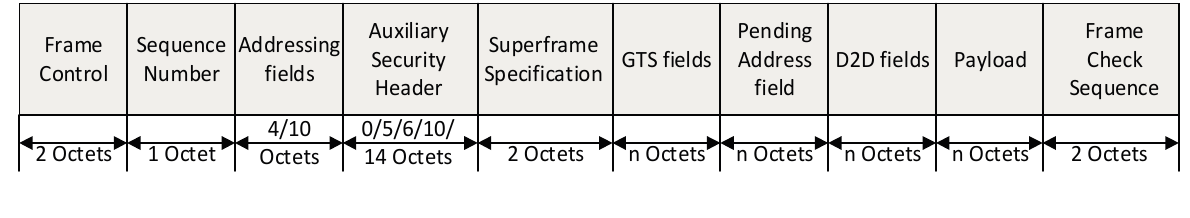
Figure 6. The format of the proposed beacon frame.